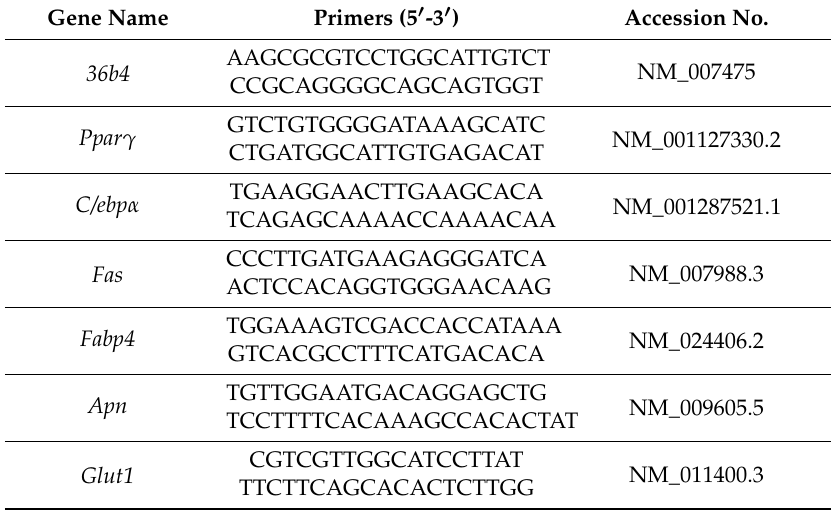
Table 1. Primer sequences used for various